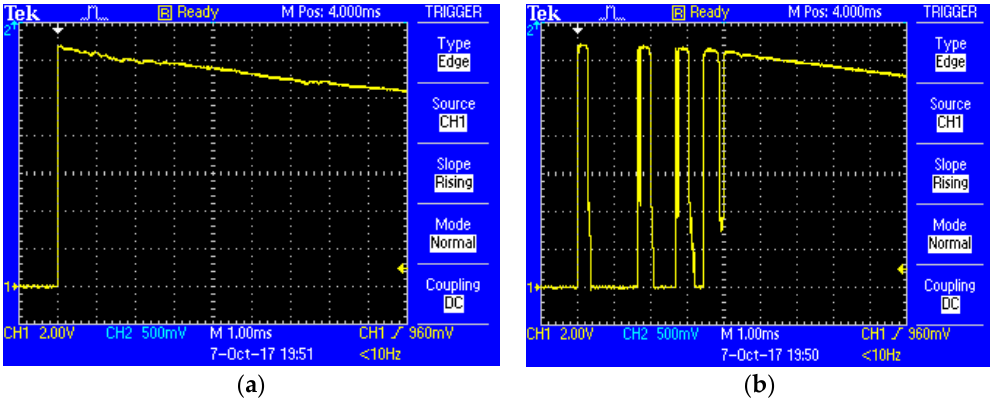
Figure 4. Oscillograms of the thyristor gate: ( a ) Continuous gate signal ( b ) Disturbed gate signal.